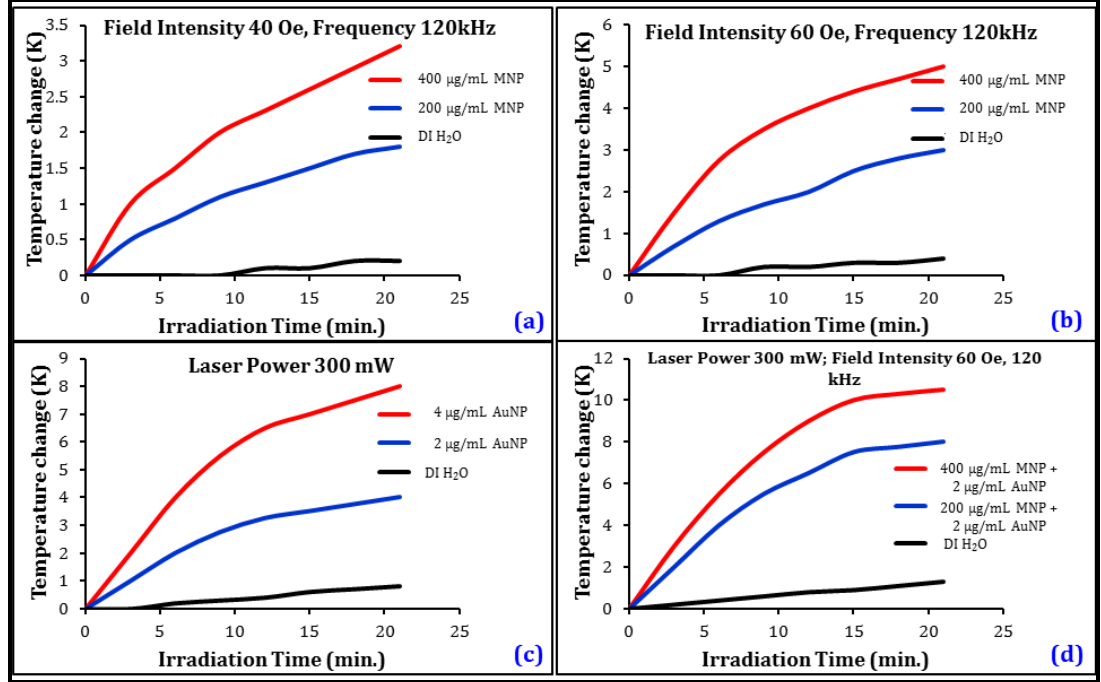
Figure 3. Remote heating response under AC magnetic field exposure as a function of CSMNS concentration at ( a ) 40 Oe, and ( b ) at 60 Oe. Frequency of the magnetic field was kept at 120 kHz. Heating response ( c ) under optical irradiation as a function of AuNP concentration, and ( d ) under hybrid optical-AC magnetic field irradiation using CSMNSs and AuNPs together in the media at various concentrations.